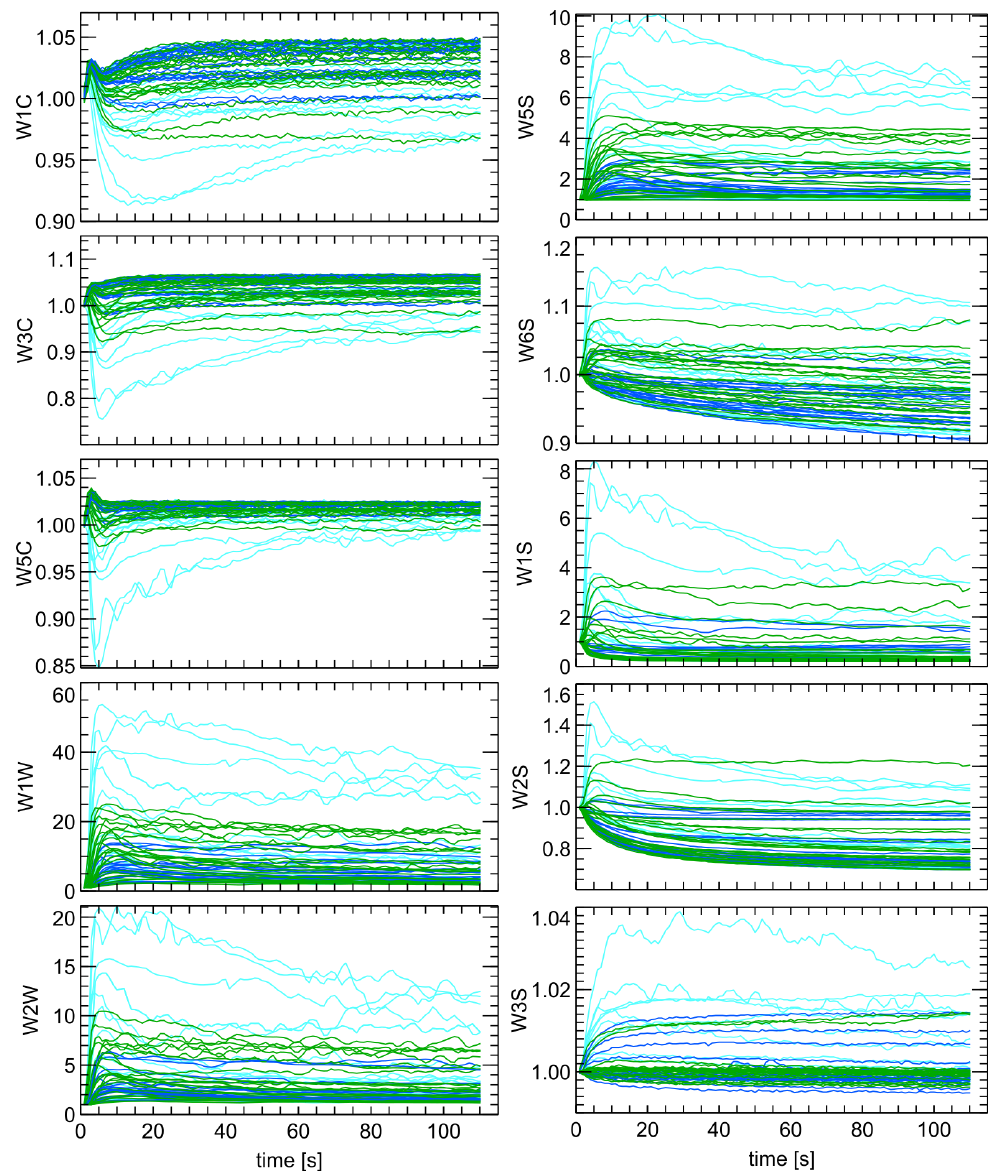
Figure 8. Sensors responses as conductance normalized by the baseline value (G/G0), for measure- ments of studied samples categories C1–C3 (cyan), G1–G3 (green) and W1–W3 (blue). The sensor type is indicated as subfigures Y-axis